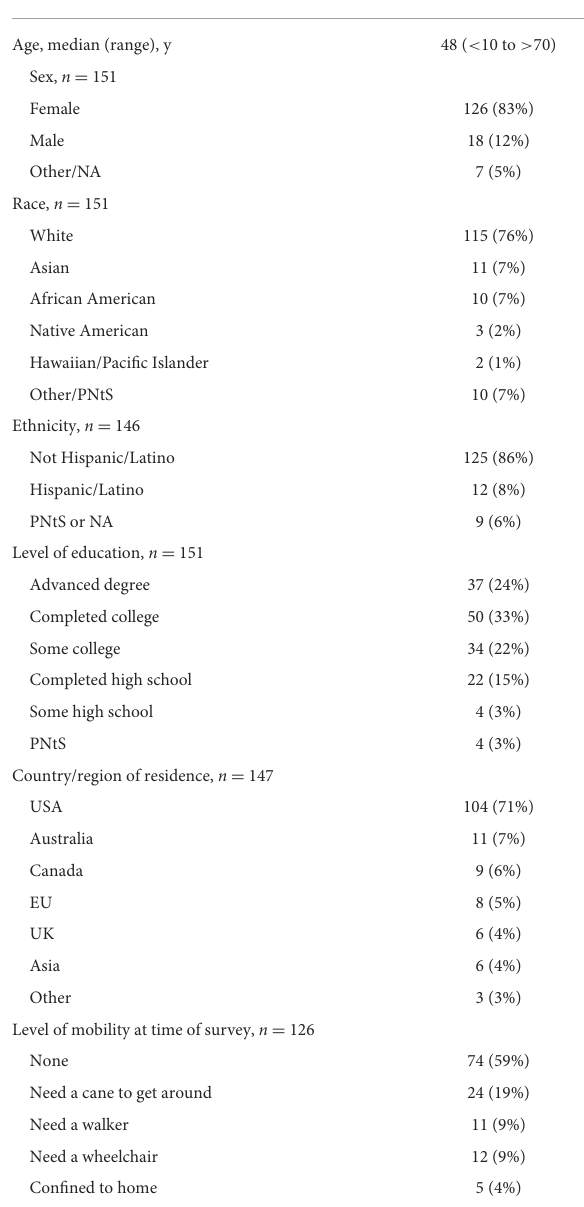
TABLE 1 Patient demographics and current level of mobility.